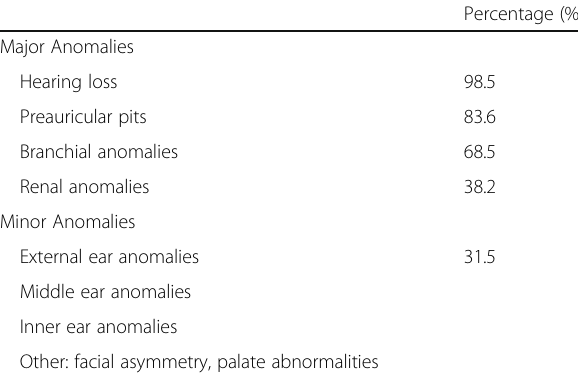
Table 1 Criteria for BOR